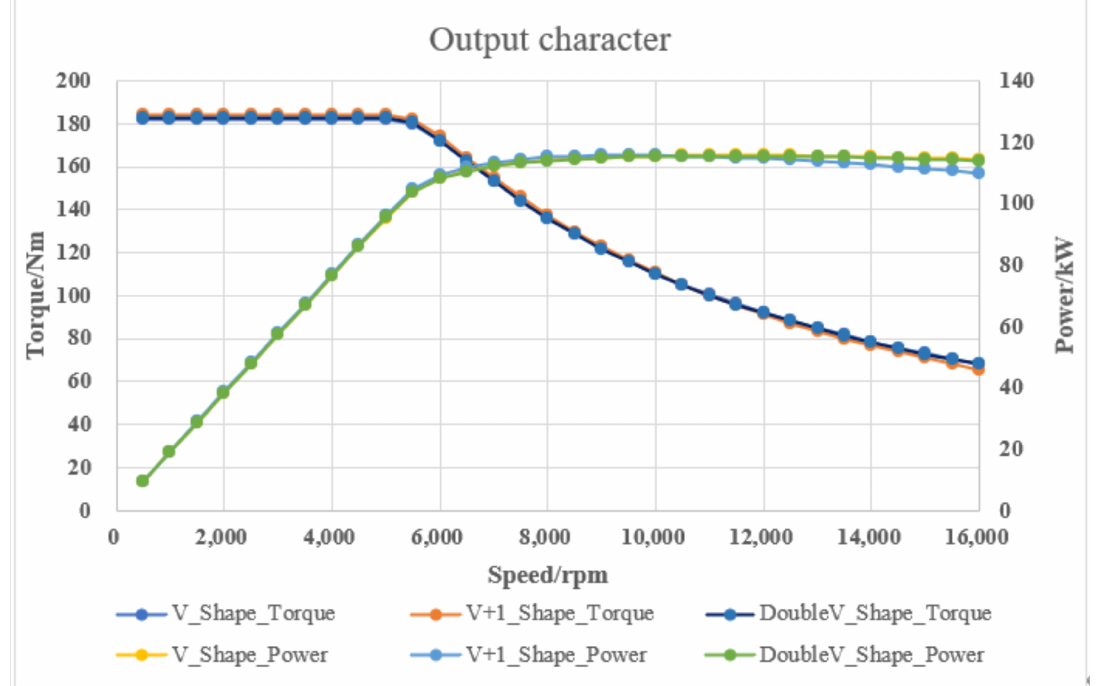
Figure 8. Output characteristics of the three different rotor shapes.